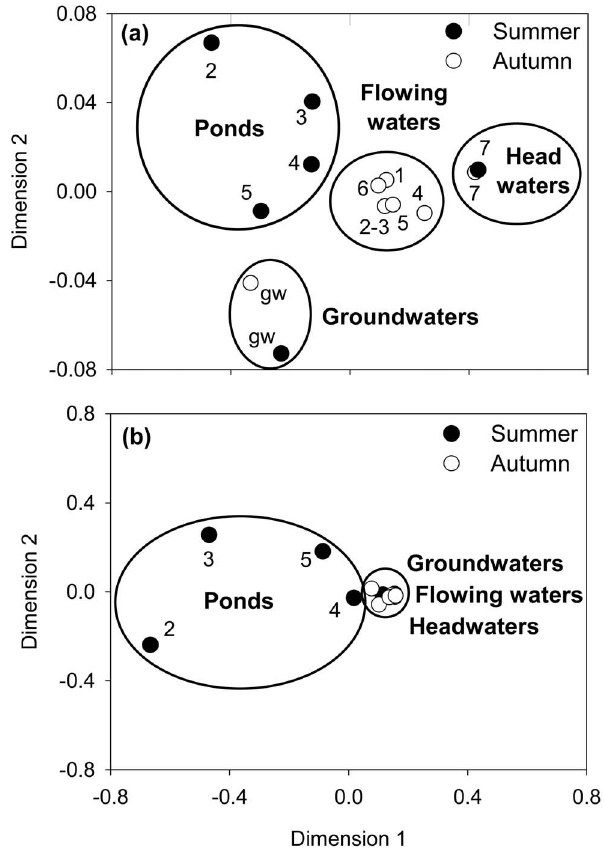
Figure 3. nMDS ordination analysis. (a) biogeochemical data as in Table 1, and (b) community composition analysed by CARD-FISH from both summer and autumn samplings.